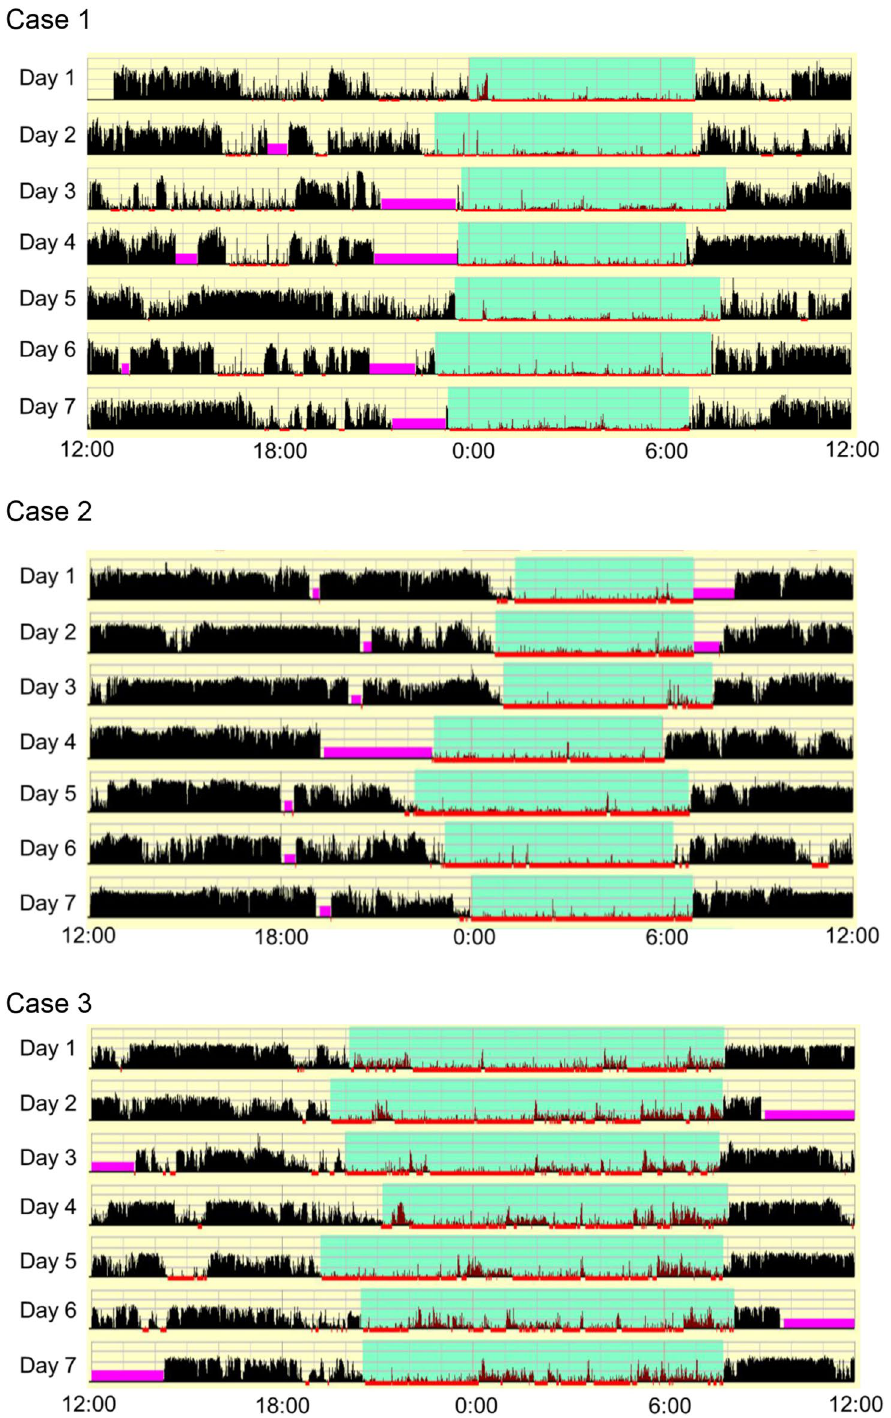
Figure 1. Actigram of three representative cases. The horizontal axis reflects the time over a 24-h period (from noon to noon). The vertical axis reflects the amount of activity recorded by the actigraph, with the black bars indicating the movement activity within one min. The light blue section indicates the period in which the participant was thought to be in bed, and the pink sections indicate the periods in which the participant had apparently removed the actigraphy